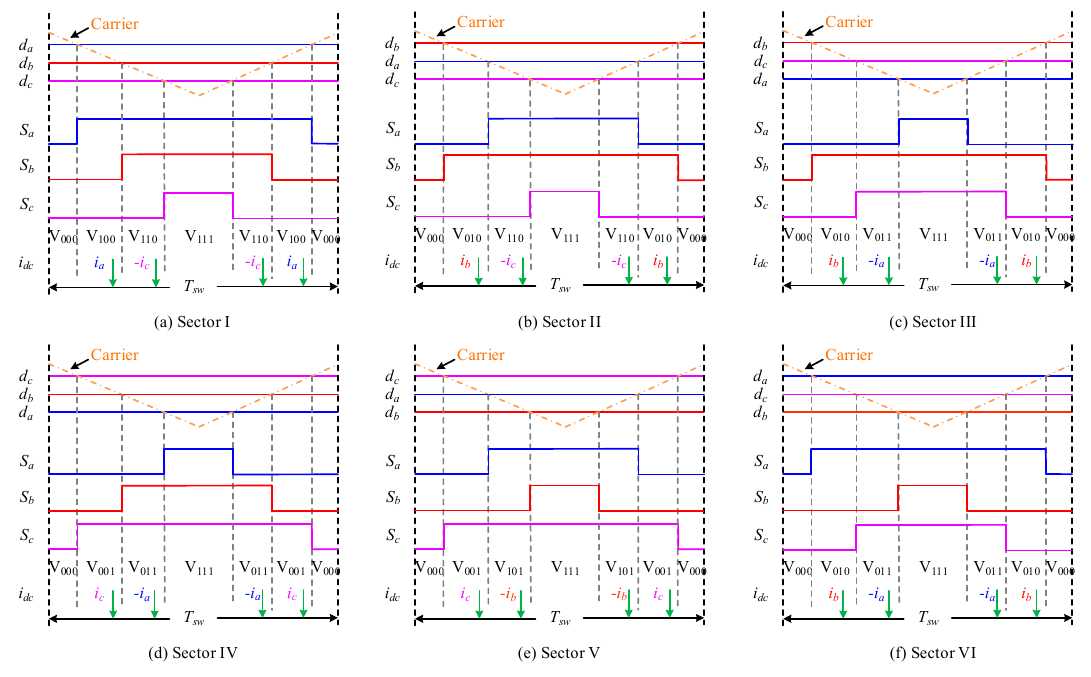
Figure 6. Switching patterns in different sectors.